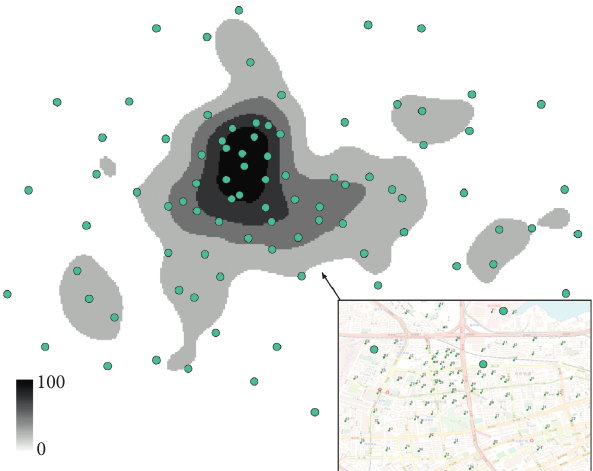
Figure 1: The fluctuation of customer requirements over time and